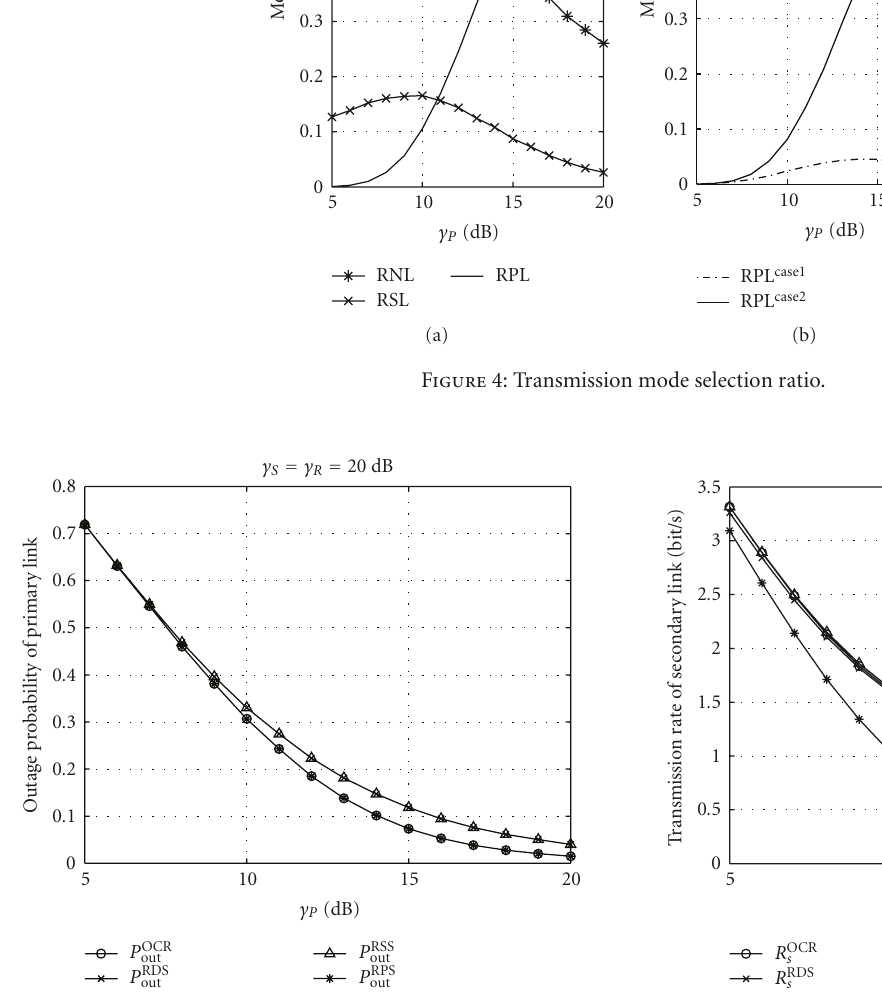
Figure 5: Outage probability of primary link. Figure 6: Transmission rate of secondary user.